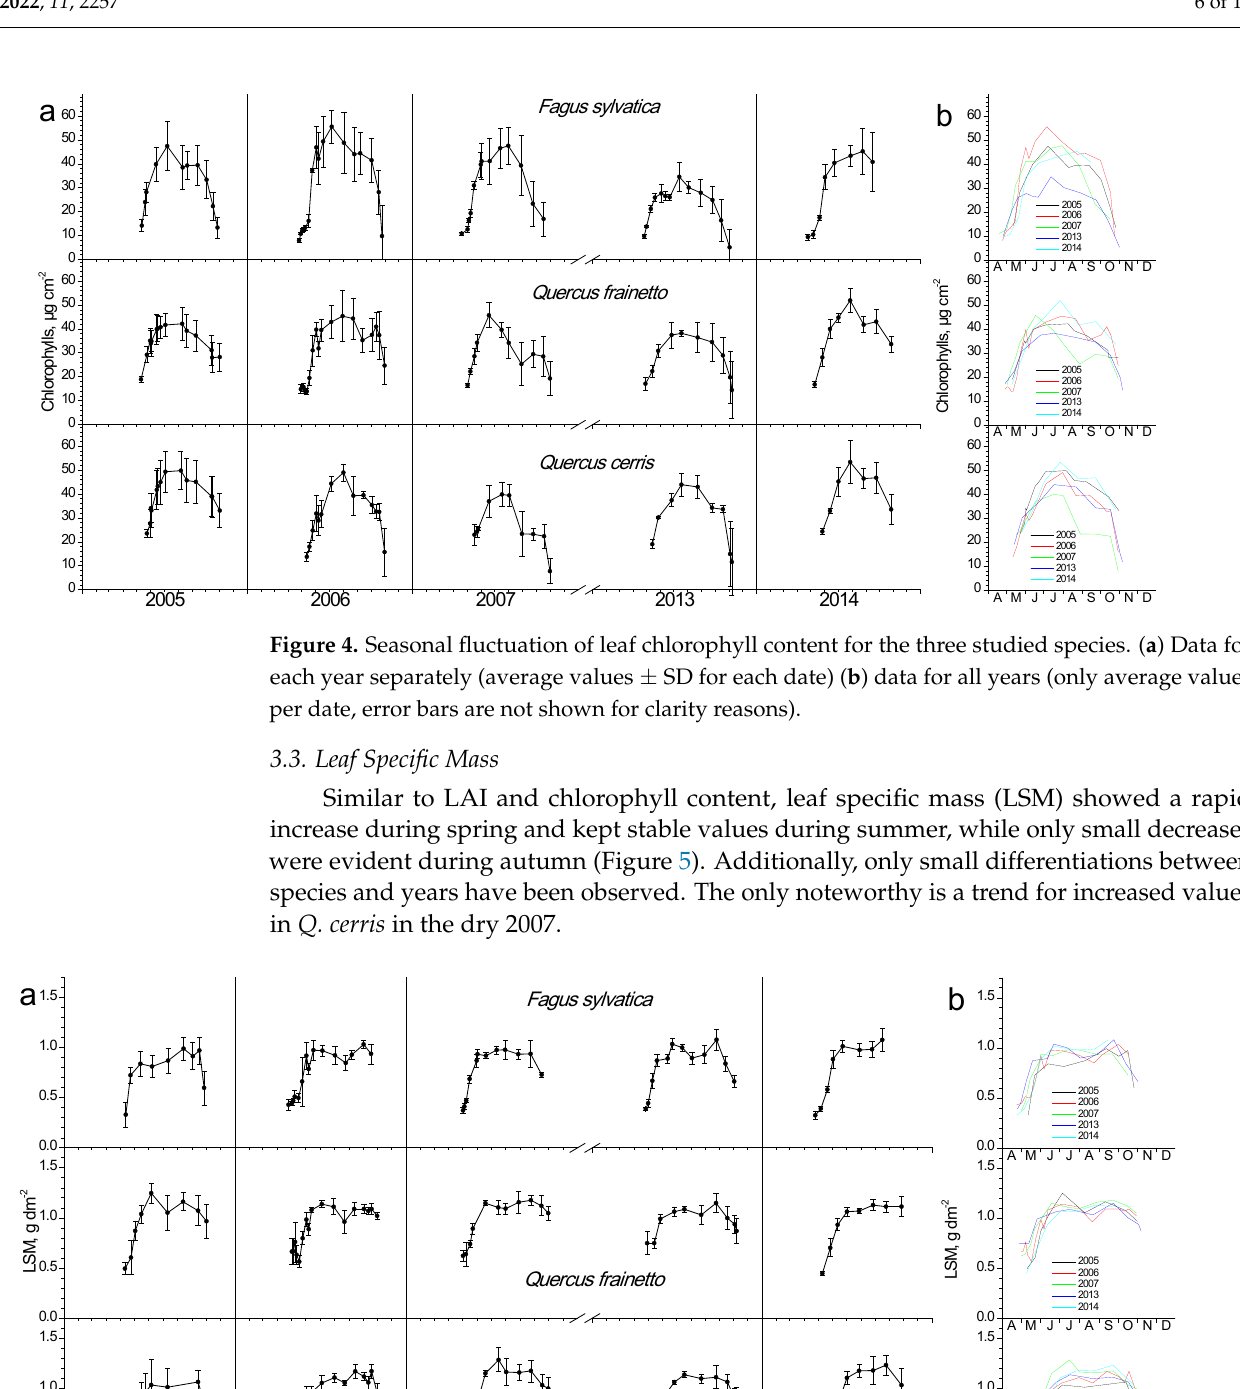
Figure 5. Seasonal fluctuation of leaf specific mass (LSM) for the three studied species. ( a ) Data for each year separately (average values ± SD for each date) ( b ) data for all years (only average values per date, error bars are not shown for clarity reasons).